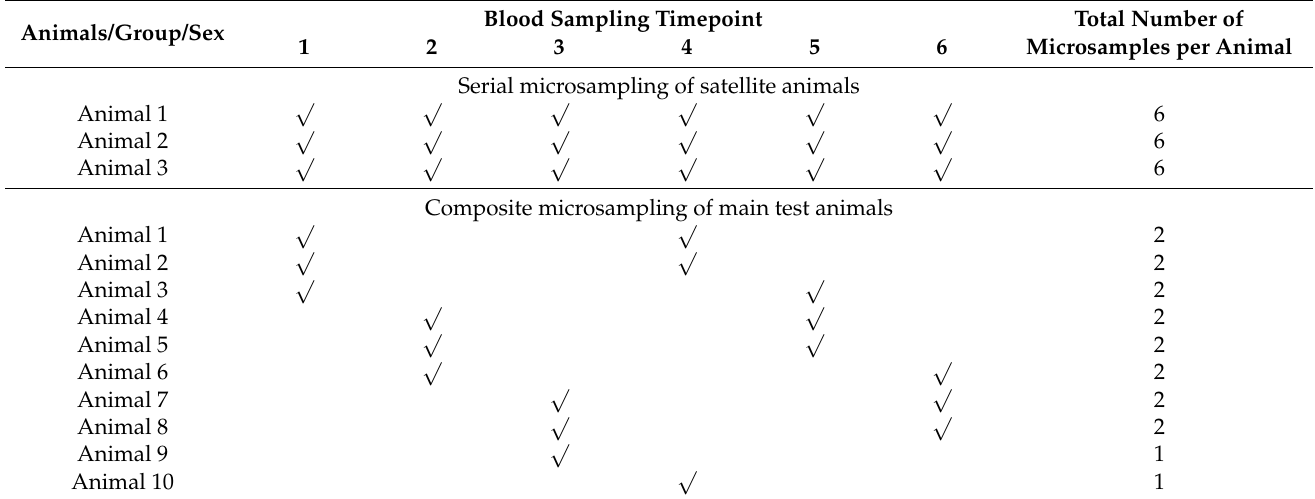
Table 1. Serial microsampling of satellite animals vs composite microsampling of main test animals.